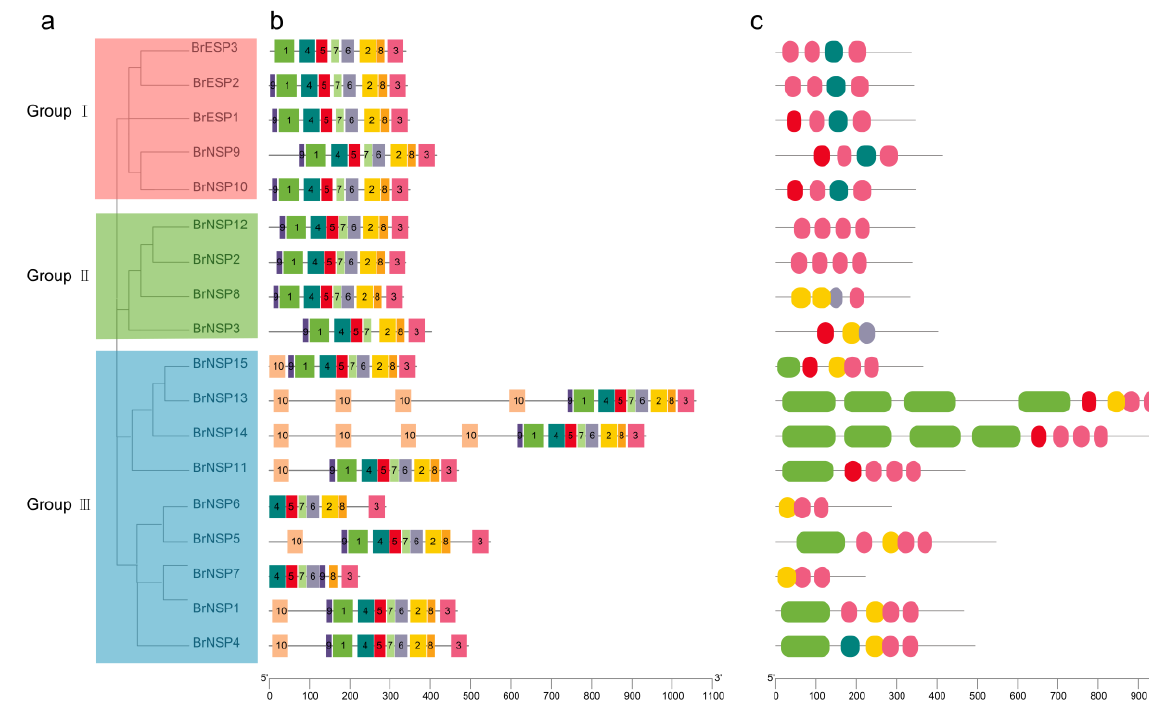
Figure 4. Gene structure of ESP and NSP gene family members in Chinese cabbage ( a ) Phylogenetic tree of the ESP and NSP gene families. Branches of the same color represent the same subgroup. ( b ) Motifs 1–10 are represented by different colored boxes. ( c ) Distribution of protein domains. ( d ) Distribution of introns and exons in ESP and NSP gene families. The green and yellow boxes and gray lines represent the UTRs, exons, and introns, respectively. The length of each nucleotide or protein sequence can be estimated using the scale at the bottom.